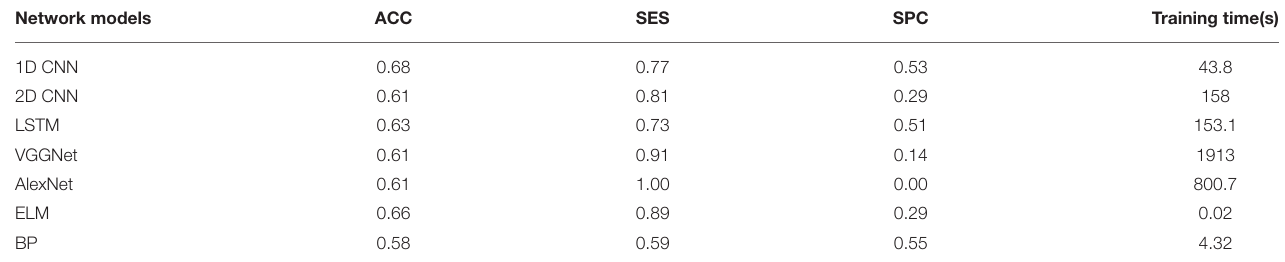
TABLE 2 | Results on walking data set. Network models